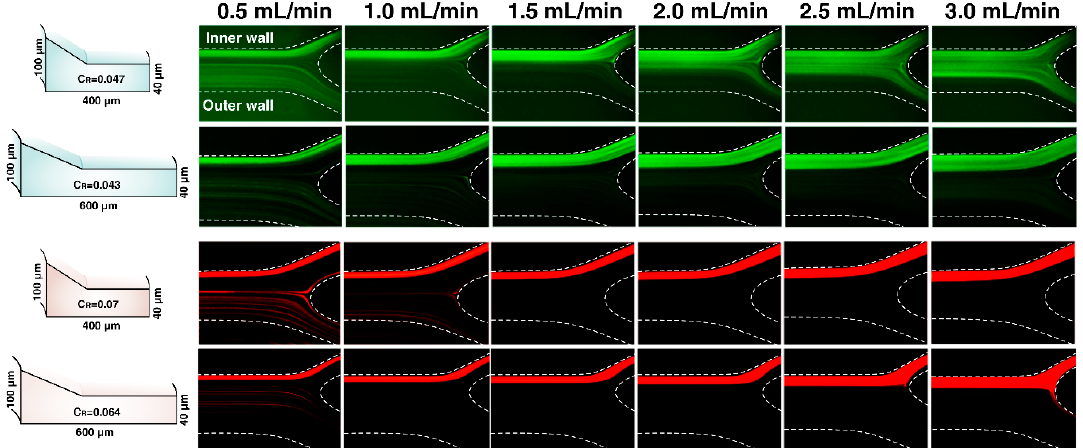
Figure 7. Fluorescent images of the outlet of Design No. 5 and Design No. 3 are shown. Cross-sectional views are given for comparison ( left ). Fluorescent stream images indicate the distribution of 4 µm ( green ) and 6 µm ( red ) at six different flow rates.